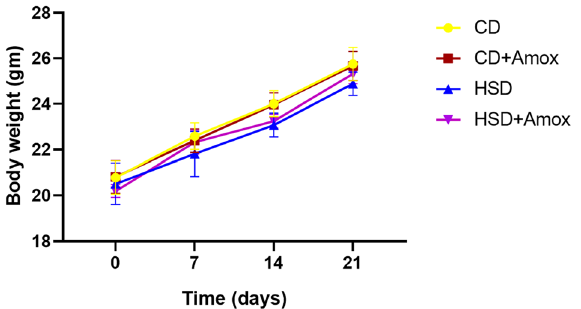
Figure 1. Effect of high-salt diet (4% in chow) and Amoxicillin treatment on body weight of mice. As shown by the data, no significant difference in body weight of mice was observed among different groups. Data represent mean ± SD; N = 6 mice/group, One Way ANOVA (* p < 0.05, ** p < 0.01, *** p < 0.001. CD: Standard—chow diet for 3 weeks; CD + Amox: Standard—chow diet for 3 weeks and subjected to Amoxicillin treatment in 3rd week; HSD: High-salt diet for 3 weeks; HSD + Amox: High-salt diet for 3 weeks and subjected to Amoxicillin treatment in 3rd